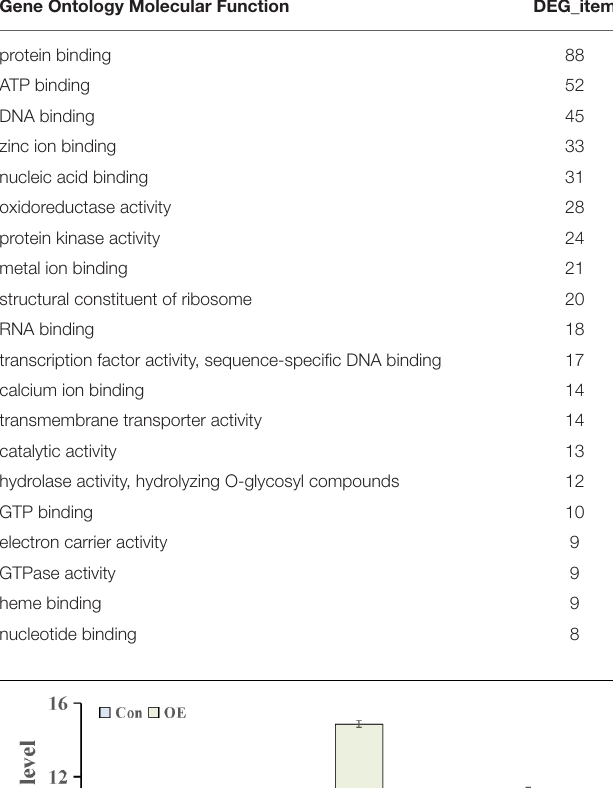
TABLE 2 | The top 20 GO molecular function based on number of common DEGs. Gene Ontology Molecular Function